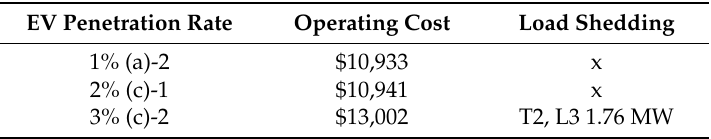
Table 6. Operating cost and load shedding results for case